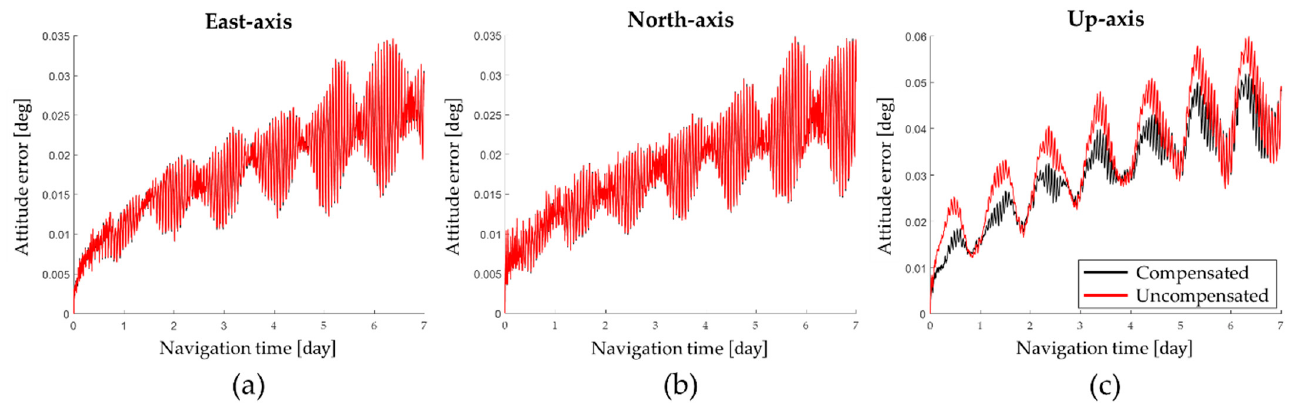
Figure 2. Attitude error according to the gyro bias error: ( a ) East − axis; ( b ) North − axis; ( c ) Up − axis.